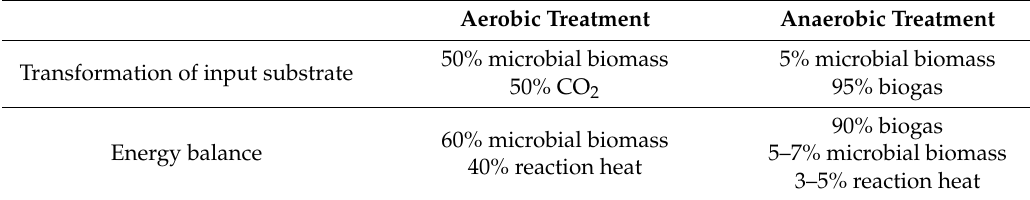
Table 5. Basic comparison of aerobic and anaerobic treatment